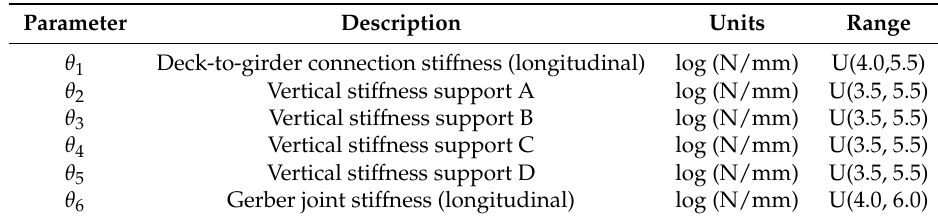
Table 6. Primary parameters with their parameter ranges (prior distributions) for the Crêt-de-l’Anneau bridge.